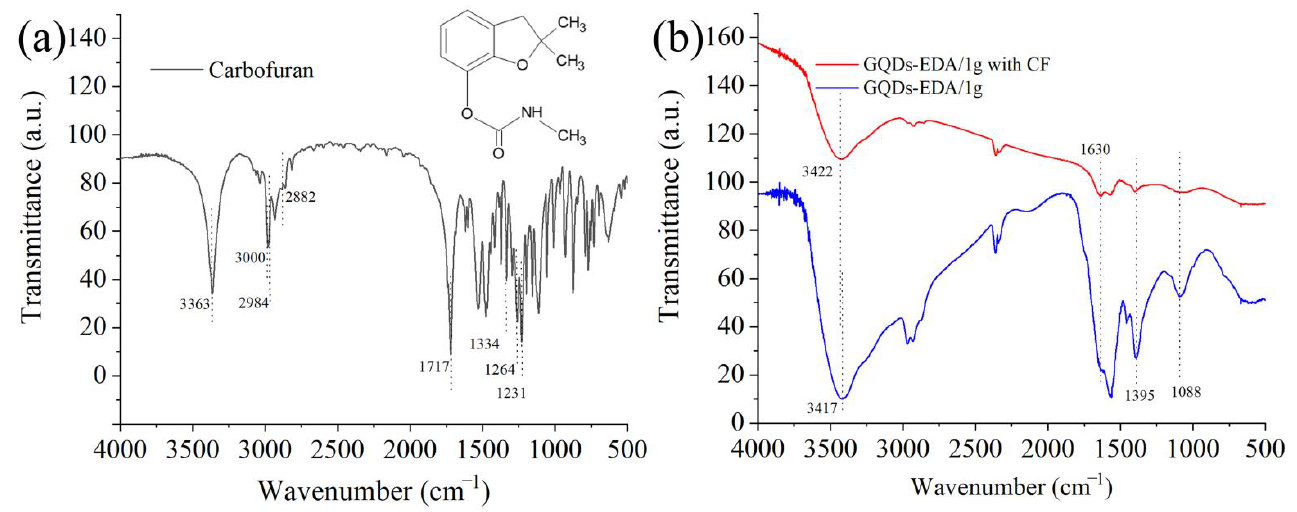
Figure 14. FTIR spectrum and structure of CF ( a ), and FTIR spectra of GQDs-EDA/1 g before and after addition of CF ( b ).